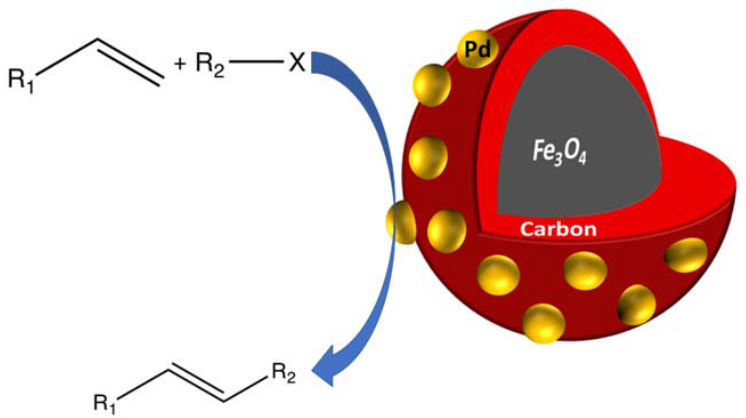
Figure 10. Graphical illustration of Pd/C@Fe 3 O 4 catalysed cross ‐ coupling reactions [66] (Adapted with permission from Elsevier).